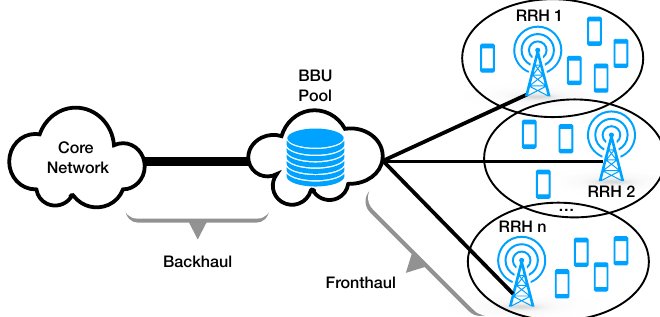
Figure 1. C-RAN architecture. BBU, Baseband Unit; RRH, Remote Radio